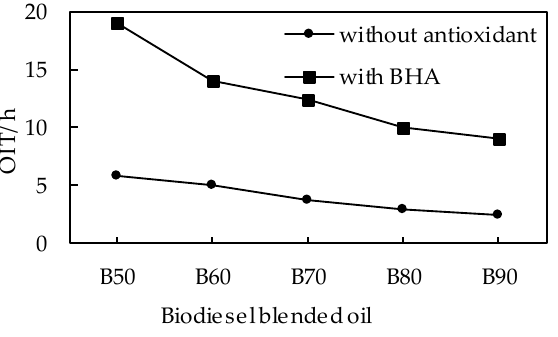
Figure 7. Combined effects of blending ratio and antioxidants on OIT.